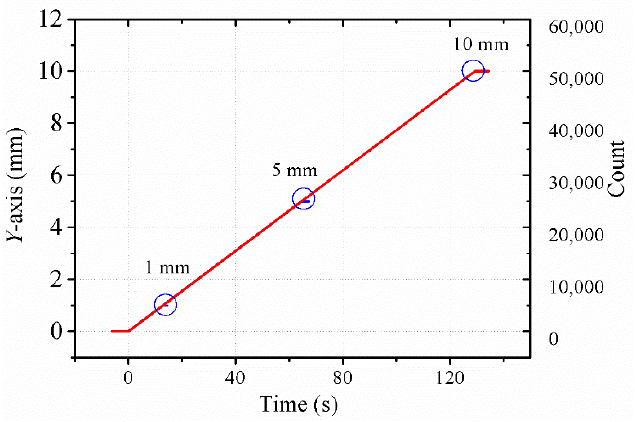
Figure 14. Motion behavior of machine tool acquired via Raspberry Pi.